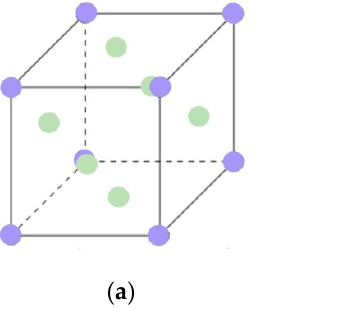
Figure 4. HCP structure. ( a ) Position of the centers of spheres; ( b ) Structure.